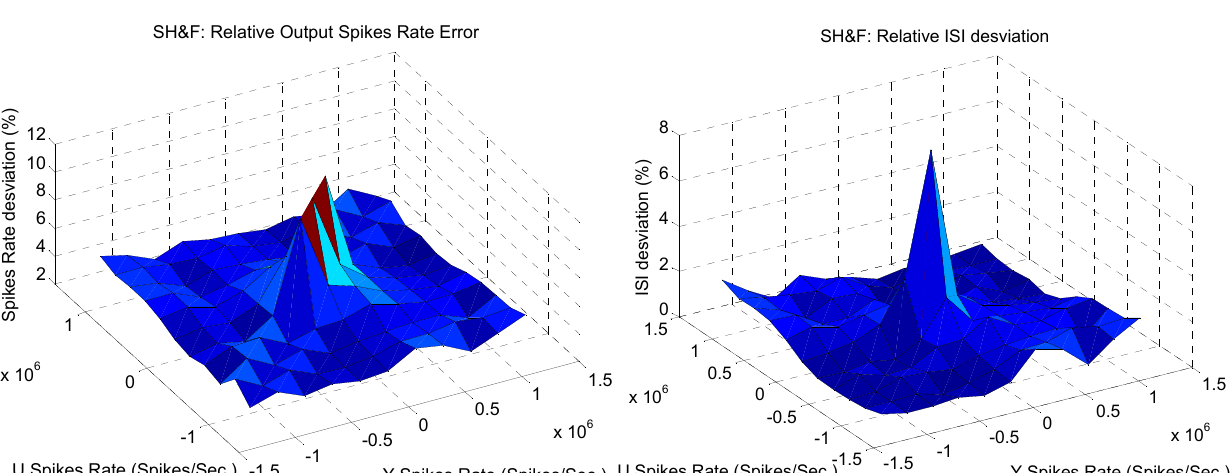
Figure 9. Spikes Hold&Fire standard deviation from ideal